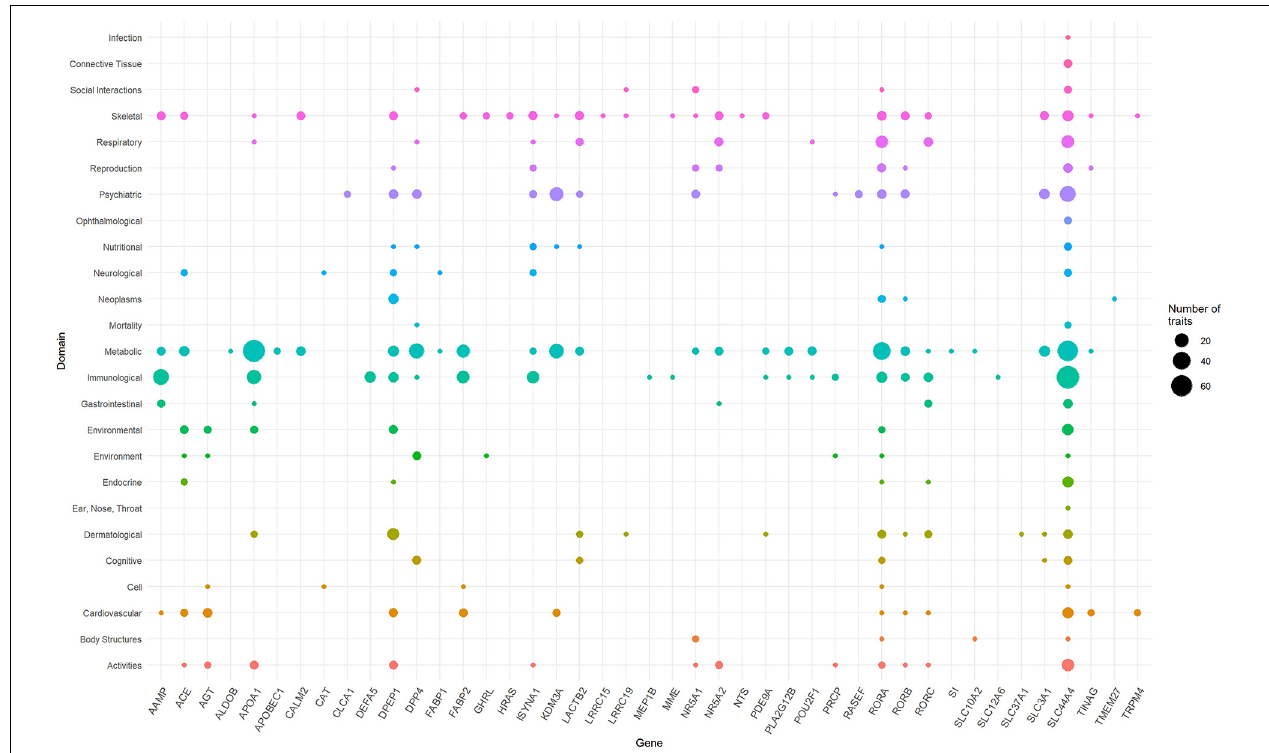
FIGURE 3 | Domain distribution of PheWAS of ACE2-network genes. The ACE2 gene network associations are grouped based on domains ( y -axis) and gene names ( x -axis). The size of the data points reflects number of phenotypes and corresponding 43 genes surviving multiple testing correction.